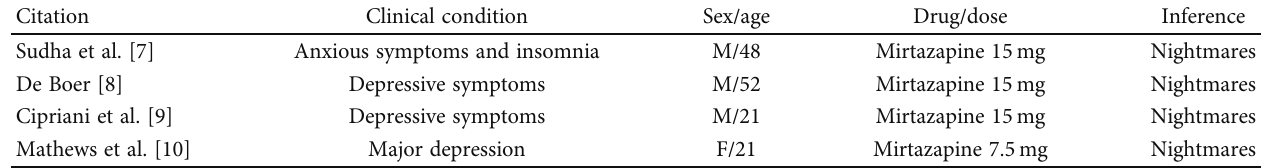
Table 1: Summary table of previous cases reporting the same side e ff ect.